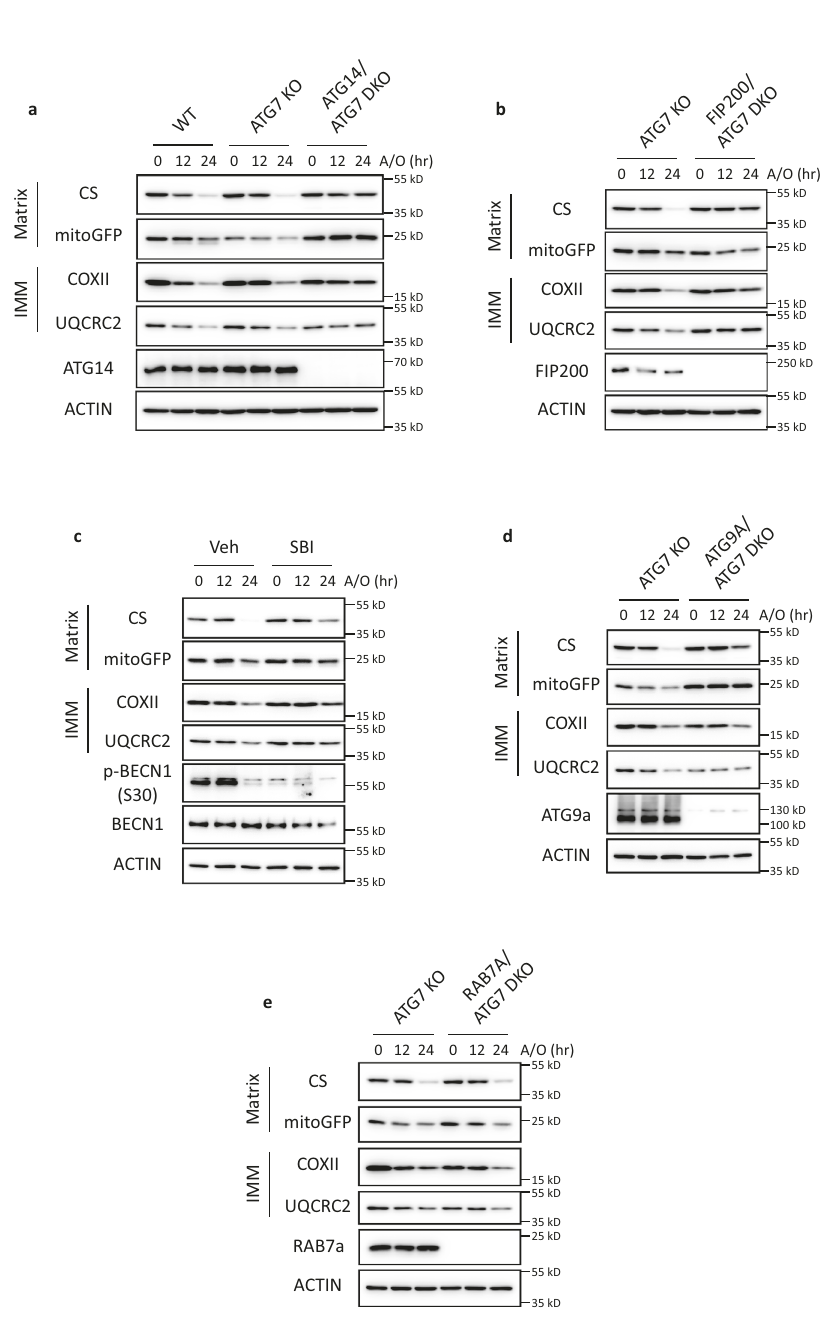
Fig. 6 ATG7-independent mitochondria clearance is impaired when autophagic secretion of mitochondria is inhibited. a WT, ATG7-KO, and ATG14/ ATG7 DKO HeLa stably expressing mCherry-Parkin were treated with A/O for the indicated duration and immunoblotted for proteins from different mitochondria compartments. b ATG7-KO and FIP200/ATG7 DKO cells were treated with A/O for the indicated duration. c ATG7-KO cells stably expressing mCherry-Parkin was treated with A/O, with or without SBI- 0206965 (25 µ M). d ATG7-KO and ATG9A/ ATG7 were treated with A/O for the indicated duration. e ATG7-KO and RAB7A/ATG7 DKO cells were treated with A/O for the indicated